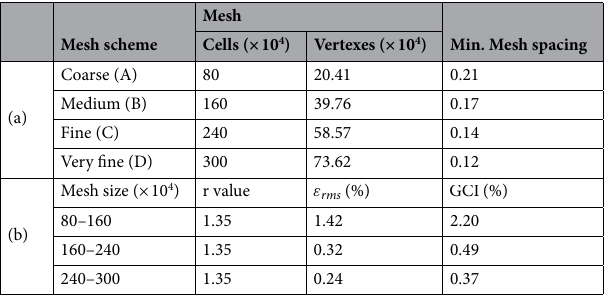
Table 1. Detailed information on the grid schemes and grid convergence